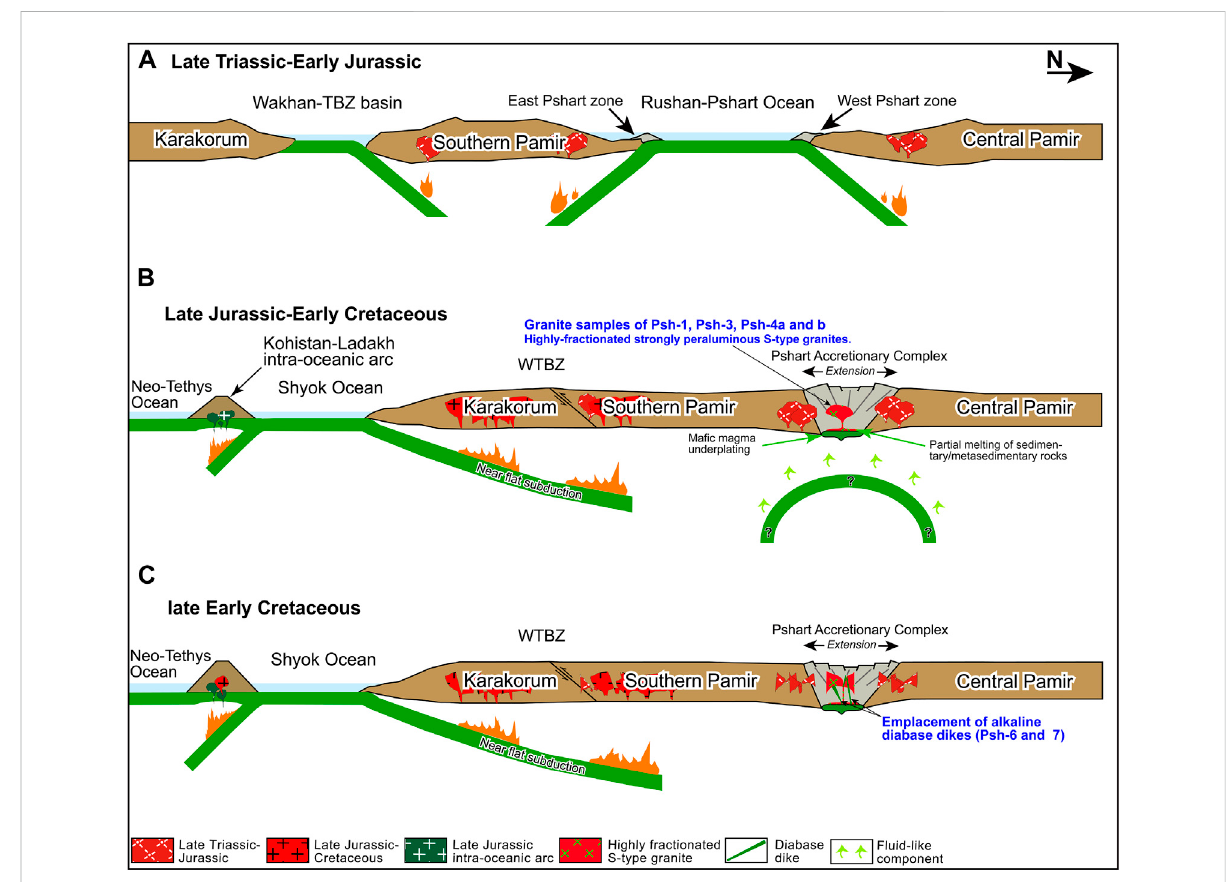
FIGURE 13 Schematic illustration of the Mesozoic evolution of Pamir: (A) Initiation of double-sided subduction of the Rushan – Pshart oceanic lithosphere, initial growth ofaccretionarycomplexes (Eastand WestPshartzones), andgenerationoftheLateTriassic – EarlyJurassicarcgranitoidsintheCentral and Southern Pamir; (B) Late Jurassic – Early Cretaceous collision of the Central and Southern Pamir, underplating of the ma fi c magma and partial meltingofthesedimentary/metasedimentaryrocks,andemplacementofhighlyfractionated,stronglyperaluminousS-typegraniteintheinitial post-collisional setting. (C) Subsequent extension and emplacement of diabase dikes. The northward subduction is adapted from Wang S. et al. (2020). The southward subduction of the Shyok oceanic lithosphere and formation of the Kohistan – Ladakh intra-oceanic arc were adapted from Saktura et al.